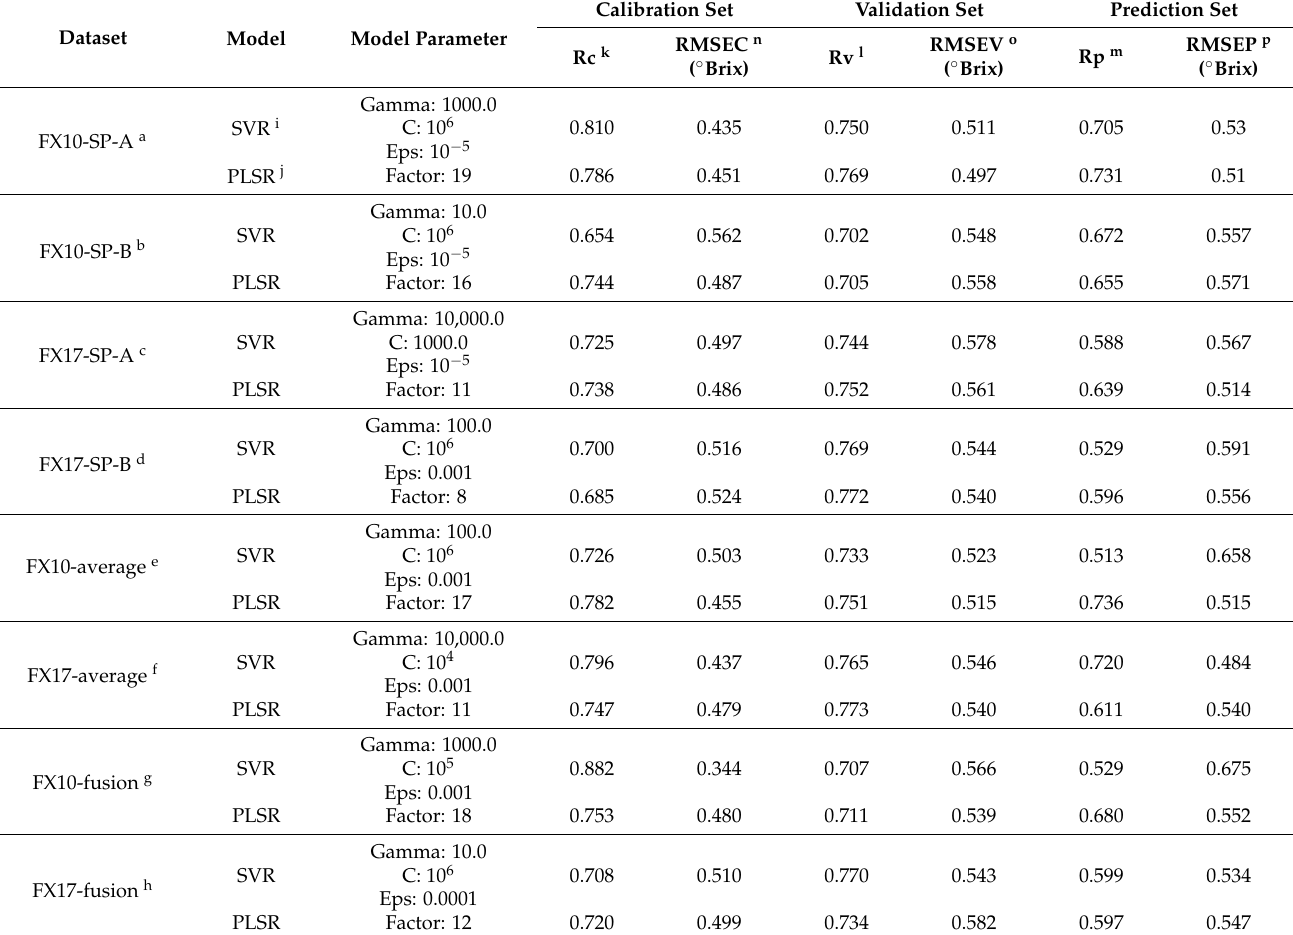
Table 2. Results and parameters of the calibration, validation, and prediction sets by SVR and PLSR